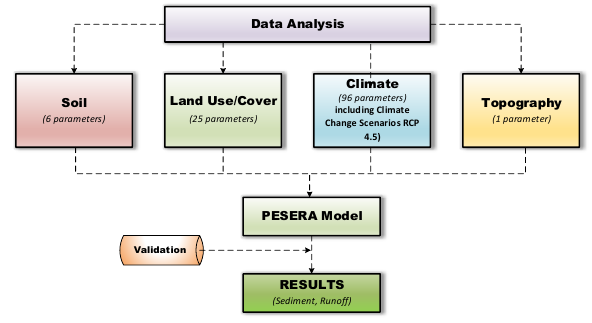
Figure 2. The flow chart of the methodology and procedures Figure 3 outlines the hydrological balance within the PESERA model. Precipitation is divided into daily storm events, expressed flow and soil erosion, and monthly precipitation, some of